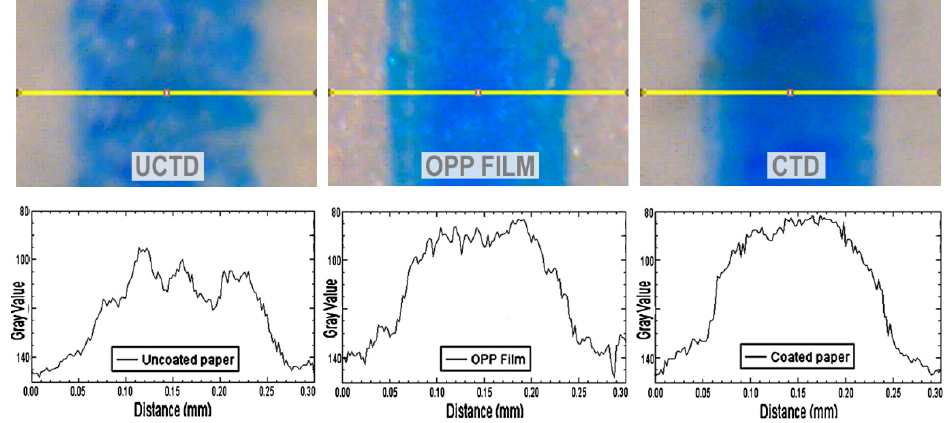
Figure 9. Two-dimensional profile of line 170 μ m width for three printing substrates.